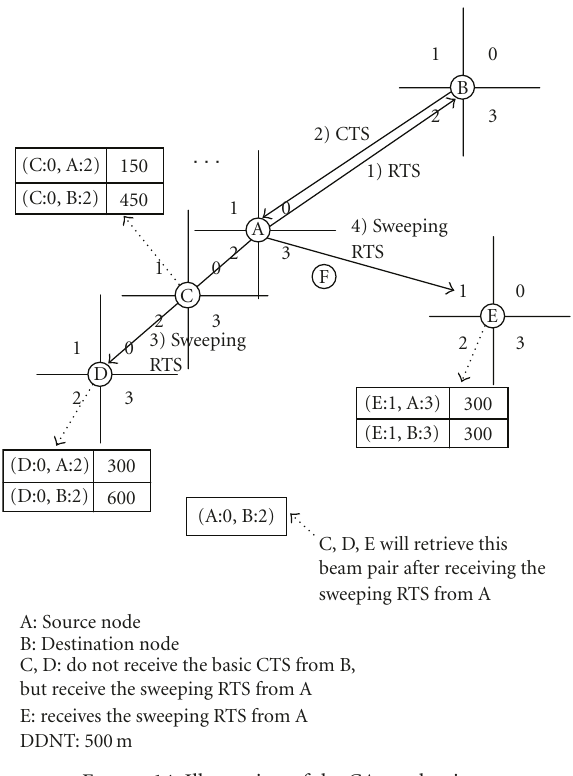
Figure 14: Illustration of the CA